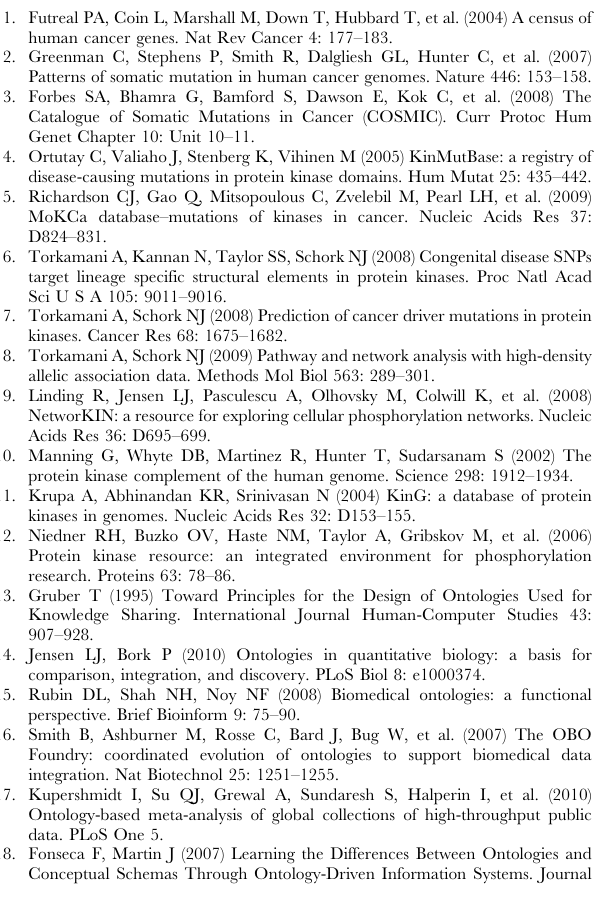
Table S4 ProKinO evaluation statistics. Table S5 Protein kinases implicated in Haematopoietic and lymphoid_tissue and having modified residue type